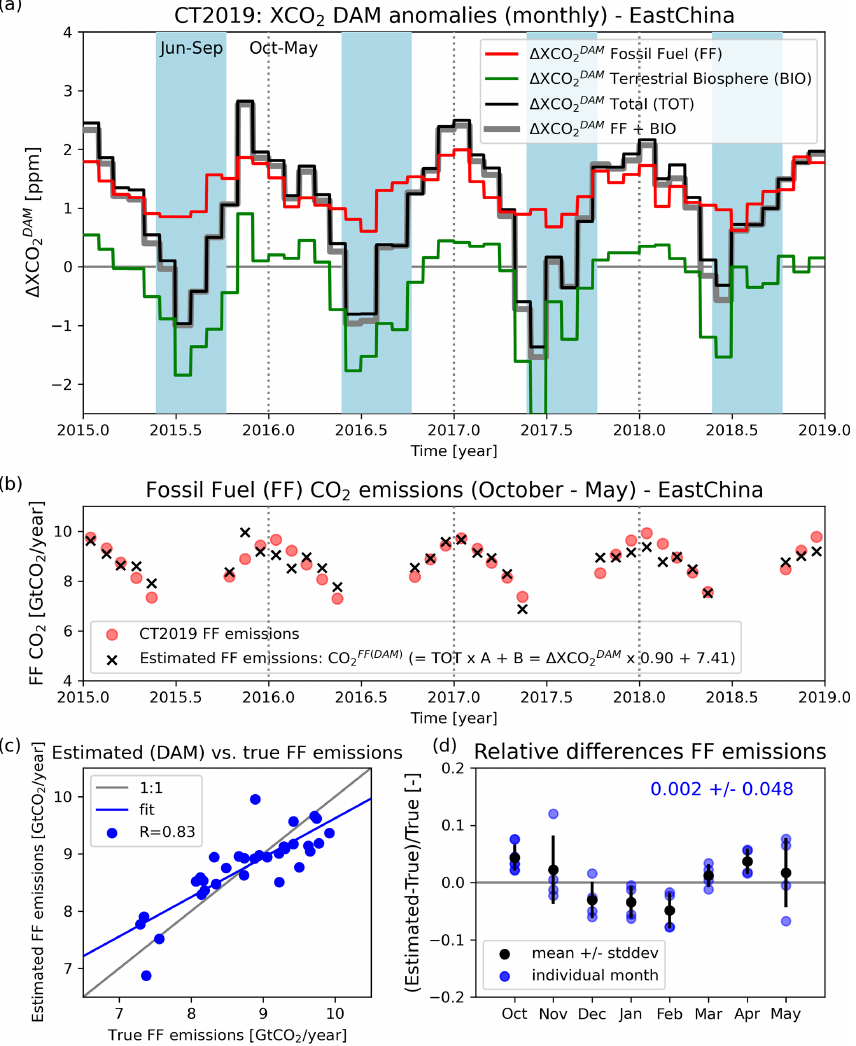
Figure 2. Results obtained by applying the DAM method to CT2019 XCO 2 for East China. (a) Different monthly (cid:49) XCO DAM components: 2 total (cid:49) XCO DAM (TOT) and its FF (red) and biogenic (BIO, green) components and their sum (FF + BIO). The non-shaded time periods 2 October to May indicate the periods analysed in this publication. (b) East China October-to-May FF CO 2 emissions (red dots) and estimated emissions CO FF ( DAM ) (black crosses) as obtained from total (cid:49) XCO DAM (TOT as shown in panel a ) using the formula shown in panel (b) . 2 2 (c) Scatter plot of estimated versus true (i.e. CT2019) FF emissions. (d) Relative difference of estimated and true emissions.